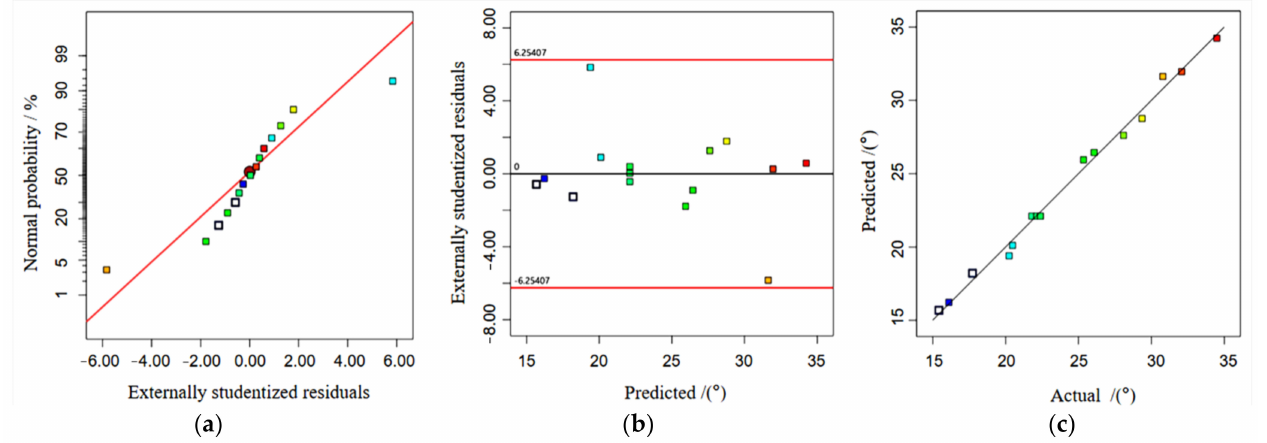
Figure 11. Residual diagnostics of the quadratic model; ( a ) Normal plot of residuals, ( b ) Residuals vs. predicted, ( c ) Predicted vs.